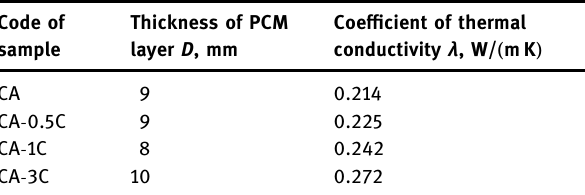
Table 7: Thermal conductivity of core material ( pure CA and composites of CA with MWCNT